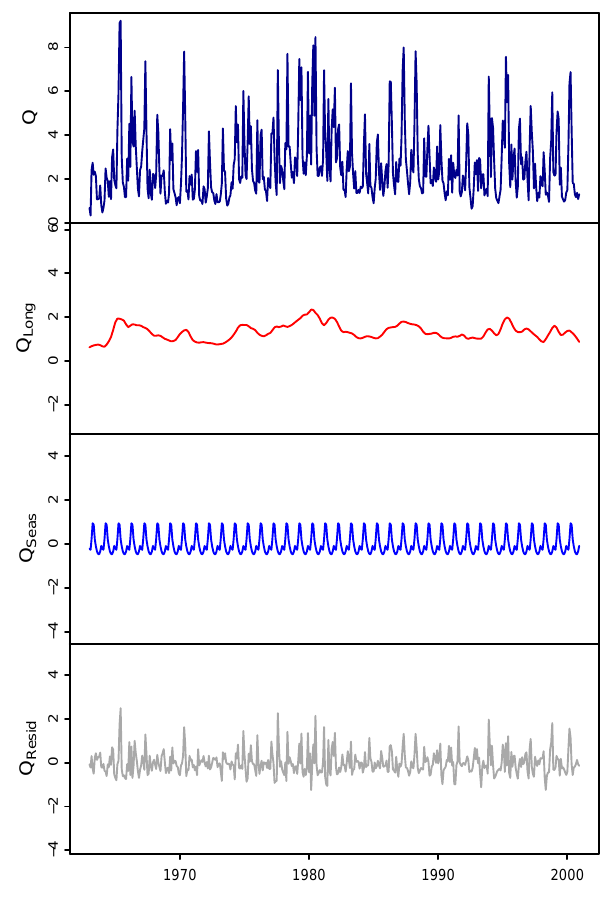
Fig. 2. Decomposition of a monthly runoff series Q : [mmd − 1 ] into low-frequency ( Q Long ), seasonal ( Q Seas ) and residual ( Q Resid )